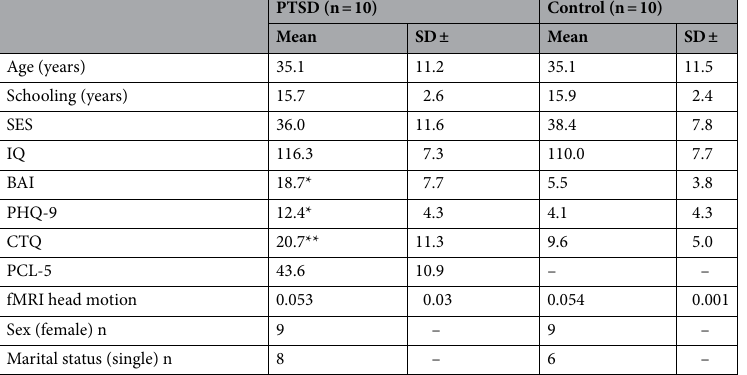
Table 1. PTSD and control evaluations (demographic, neuropsychological and trauma-related scores). There were no statistically significant differences between the two groups for SES, IQ, and Schooling. SES Socioeconomic status according to Associação Brasileira de Empresas de Pesquisa (www. abep. org): we report the final score, rather than the strata (letters A to D), IQ intelligence quotient, BAI beck anxiety